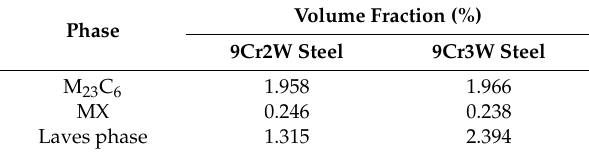
Table 4. The volume fraction of second phases in the steels at 650 ◦ C as calculated by Thermo-Calc.